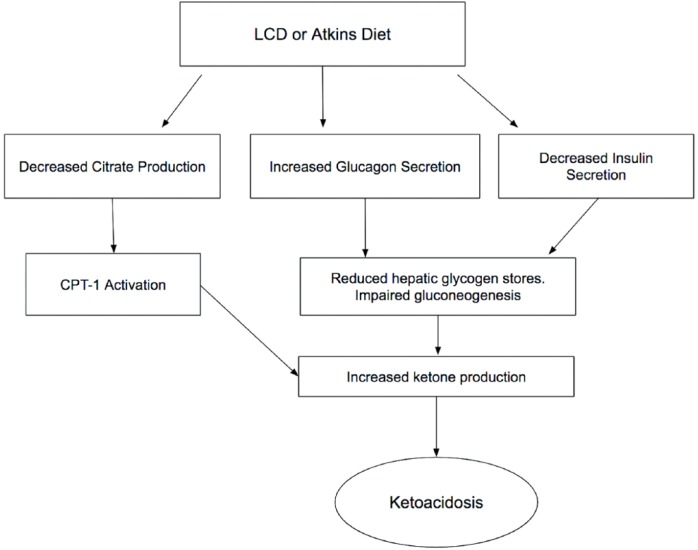
Flow sheet of the pathophysiology of nondiabetic ketoacidosis.